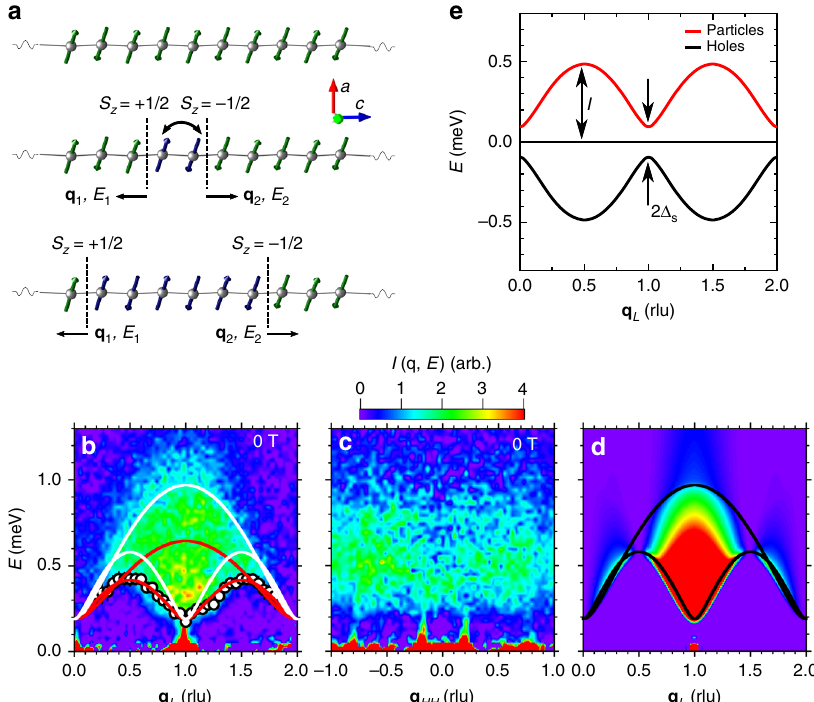
Fig. 1 Spinons on decoupled chains. a An anisotropic AFM spin chain (top). If two spins are interchanged, two domain walls are created between the original antiferromagnetic domain (green) and a new domain (blue) (middle). Those domain walls form the basis for the propagating states carrying energy and momentum quanta (bottom). b The magnetic excitation spectrum and dispersion along the q L direction in reciprocal space measured at T = 0.1 K, summed over − 1 ≤ q HH ≤ 1 rlu. The lower boundary of the spectrum (white circles) is shown along with the boundaries of the two spinon continuum obtained by fi tting the lower boundary (red lines, Δ = 3.46) and comparing the total measured spectrum to theory (white lines, Δ = 2.6) 26 . The color scale for parts b – d is shown above part c . Error bars represent one standard deviation. c The magnetic excitation spectrum along the q HH direction in reciprocal space measured at T = 0.1 K, summed over 0 ≤ q L ≤ 2 r.l.u. d The spinon spectrum obtained from tDMRG calculations for the XXZ model Eq. (1) with Δ = 2.6 on the 96-site chain. The continuum boundary (black lines) is the same as that shown in b for Δ = 2.6. e The dispersions of particle-like (red) and hole- like (black) spinons, symmetric about E = 0 in zero magnetic fi eld, are sketched with the real Δ = 2.6 parameters for Yb 2 Pt 2 Pb. The bandwidth parameter I and the spinon gap Δ S are indicated by arrows, with 2 Δ S the energy separation between the particle and hole bands at q L = 0, 1, and 2